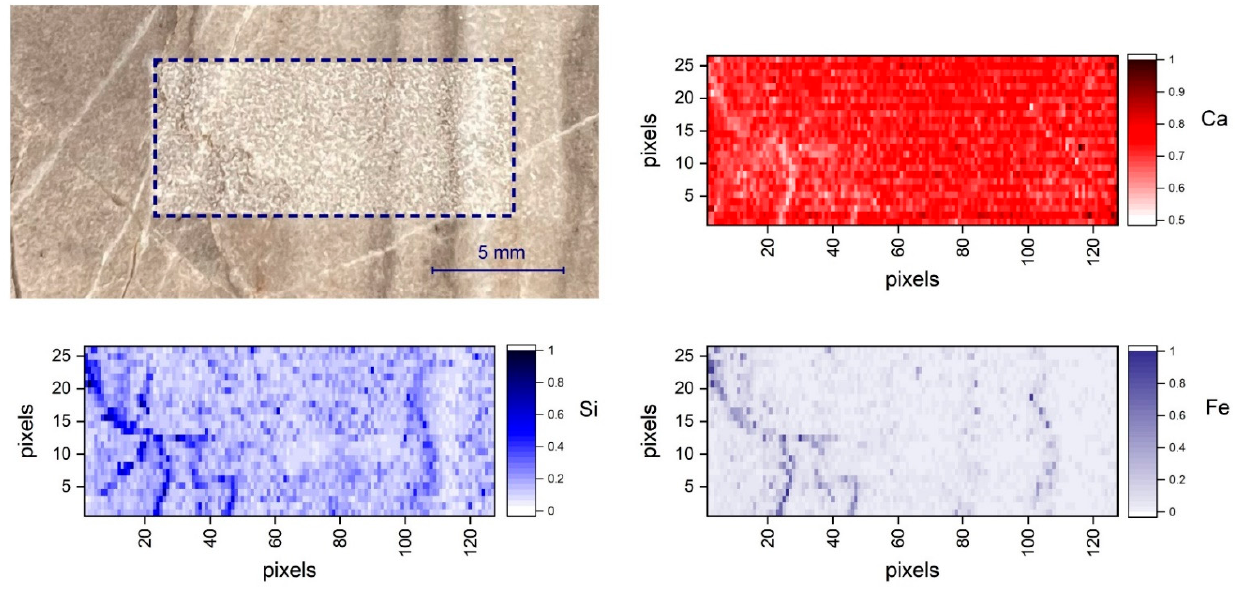
Figure 7. Ca, Si, and Fe LIBS elemental maps corresponding to a scanned area of 15 mm × 5.2 mm of sample S 33 .